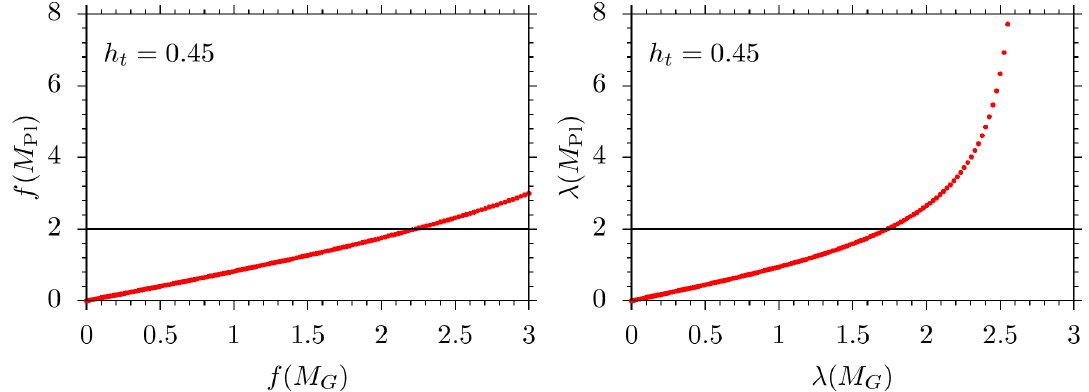
Figure 1 . Relation between the GUT and Planck scale values of f (left) and λ (right) defined in eq.